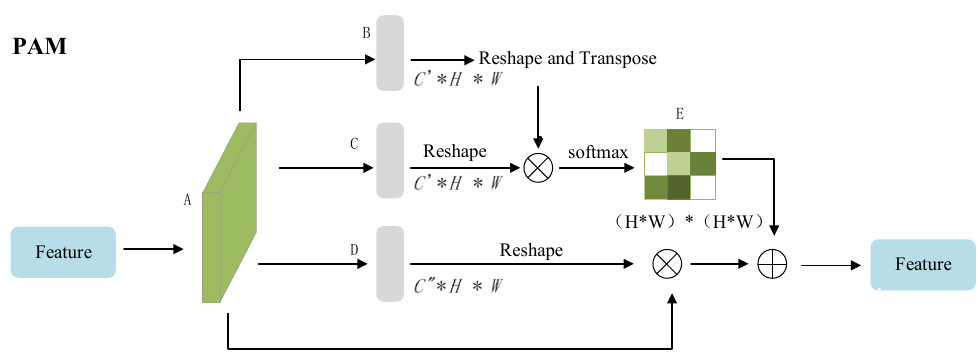
Figure 6. The structure of the PAM. B = key feature maps, of which dimension is C’*H*W , C = query feature maps, of which dimension is C’*H*W , D = value feature maps, of which dimension is C’*H*W .